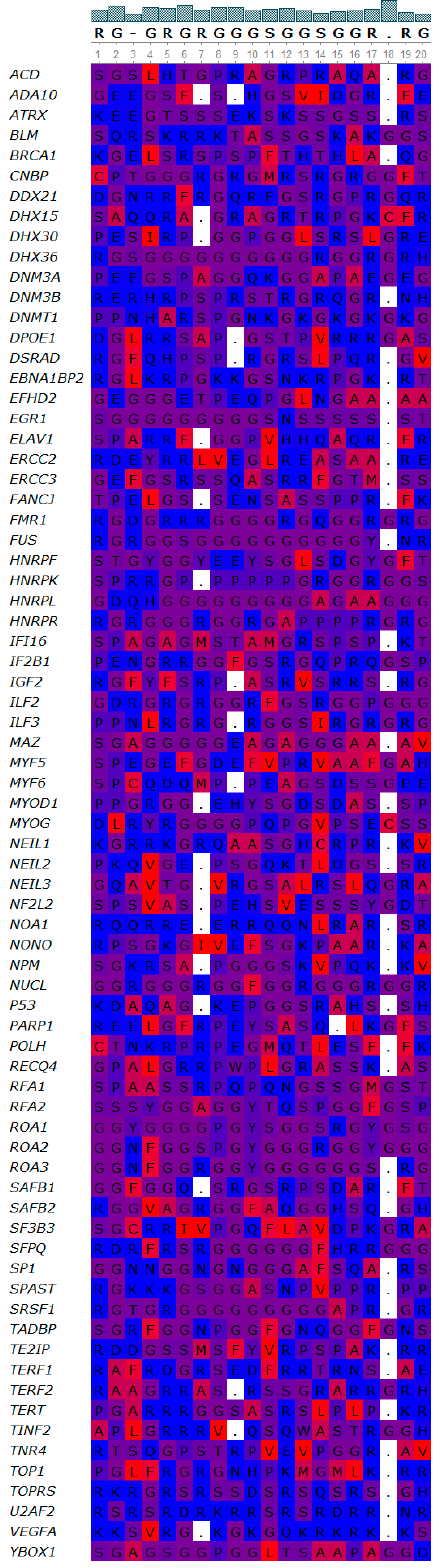
Figure 5. Overlay of NIQI sequence for individual proteins. Gaps are depicted with dots. Colors show hydrophobicity—blue are hydrophilic amino acid residues, red are hydrophobic amino acid residues.